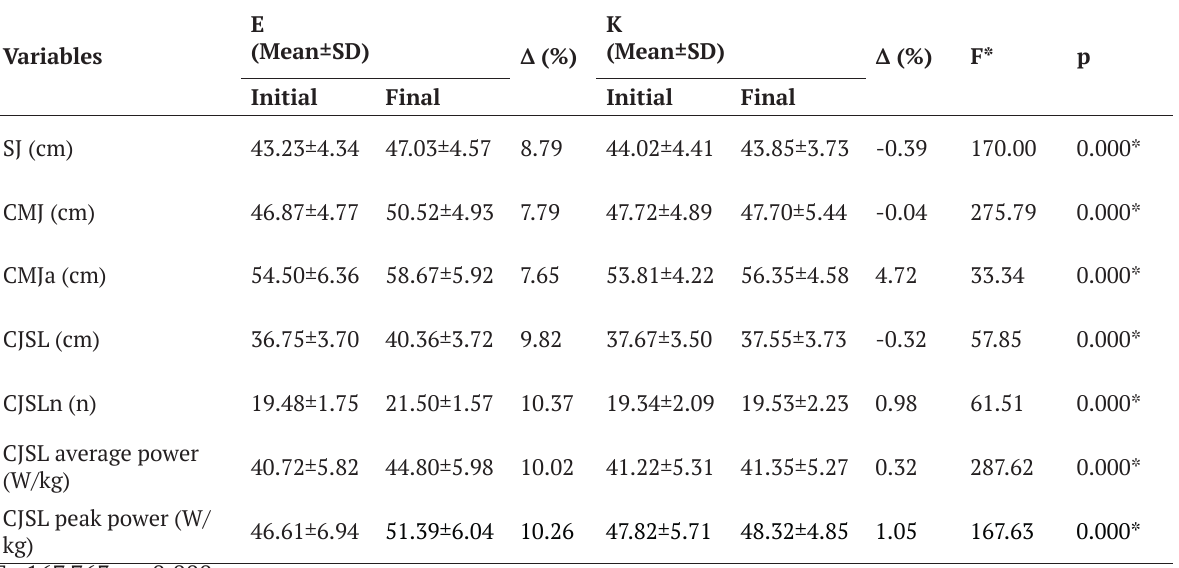
Table 2. Difference between the E and K groups in the variables of lower limb explosive strength after the treatments applied